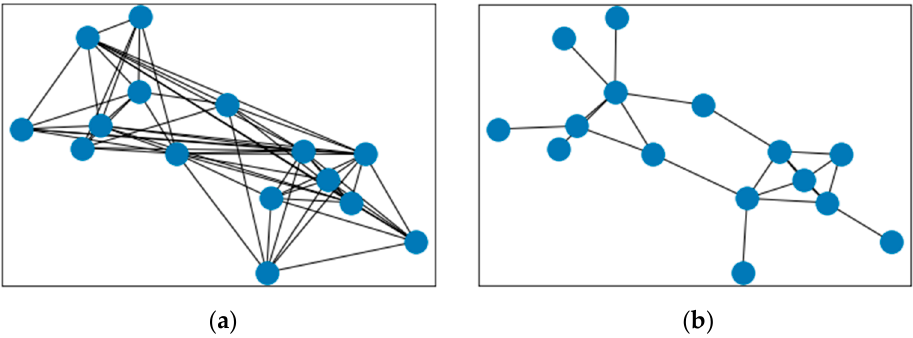
Figure 4. Merchant-to-merchant network4, ( a ) merchant network by method 14; ( b ) merchant network by method 3.